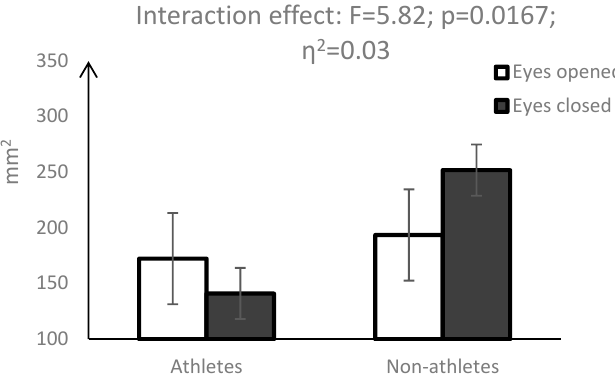
Figure 1. Mean values and 95% confidence interval for the ellipse of the COP shifts area (AoE) along with the results of the interaction between group and vision factors.